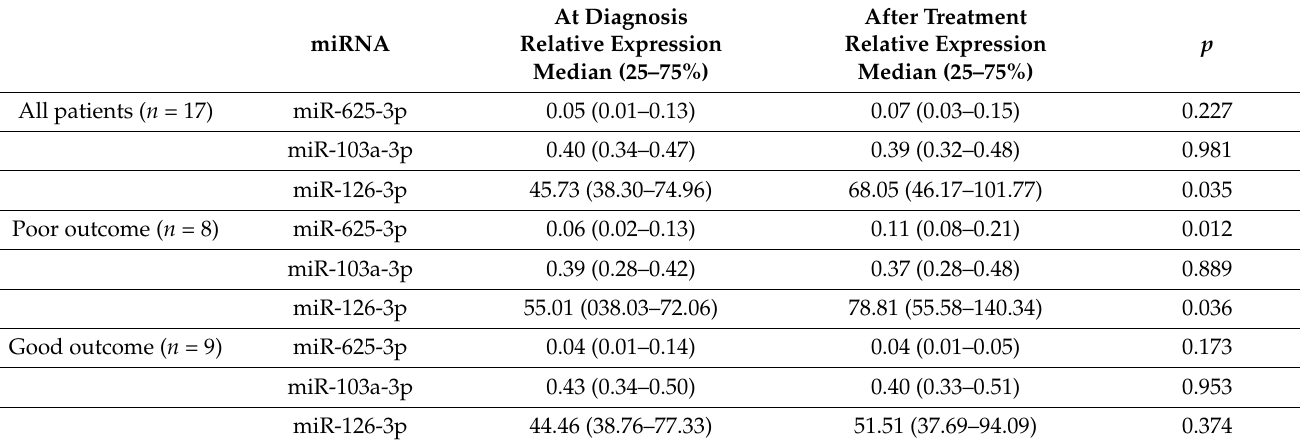
Table 2. Comparison of expression of serum EV-enriched miRNAs at diagnosis and after treatment in malignant mesothe- lioma patients. After Treatment At Diagnosis Relative Expression miRNA Relative Expression Median (25–75%) Median (25–75%)